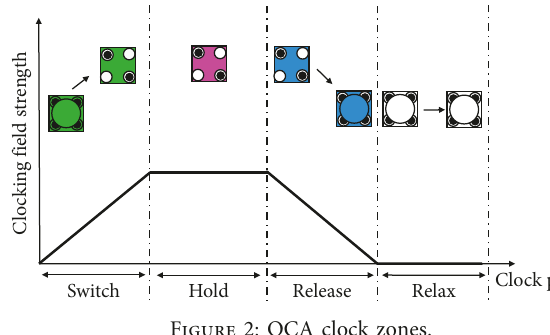
Figure 2: QCA clock zones.